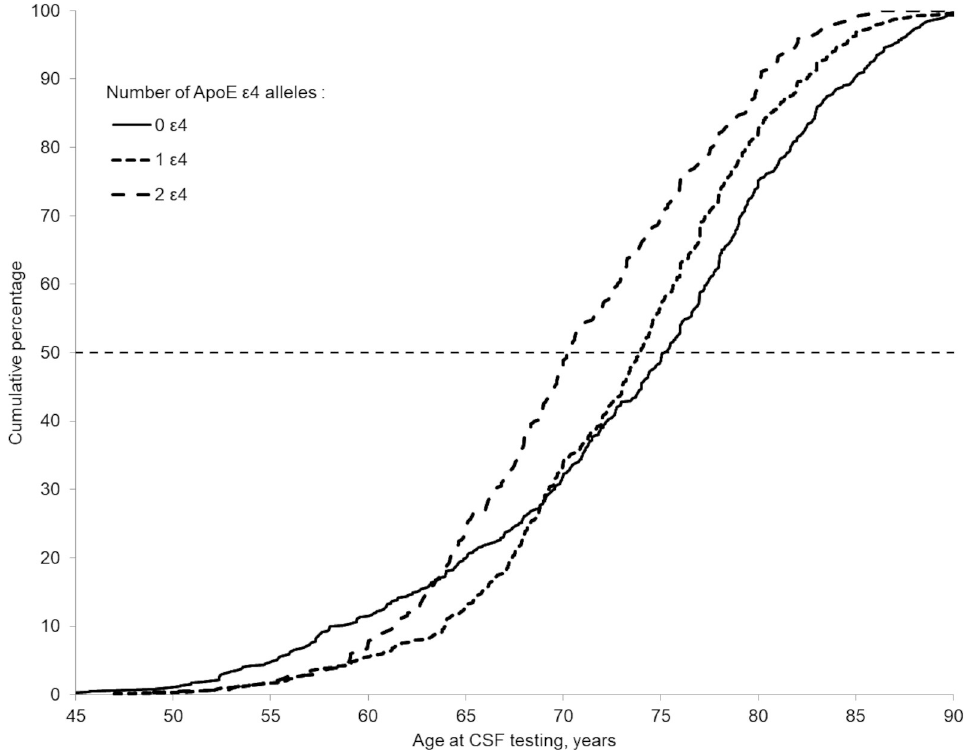
Fig 1. Cumulative proportion of CSF AD cases as a function of age and APOE ε 4 status. The dashed horizontal line shows the median of distribution per group of APOE ε 4 status. AD, Alzheimer disease; APOE , apolipoprotein E; CSF, cerebrospinal